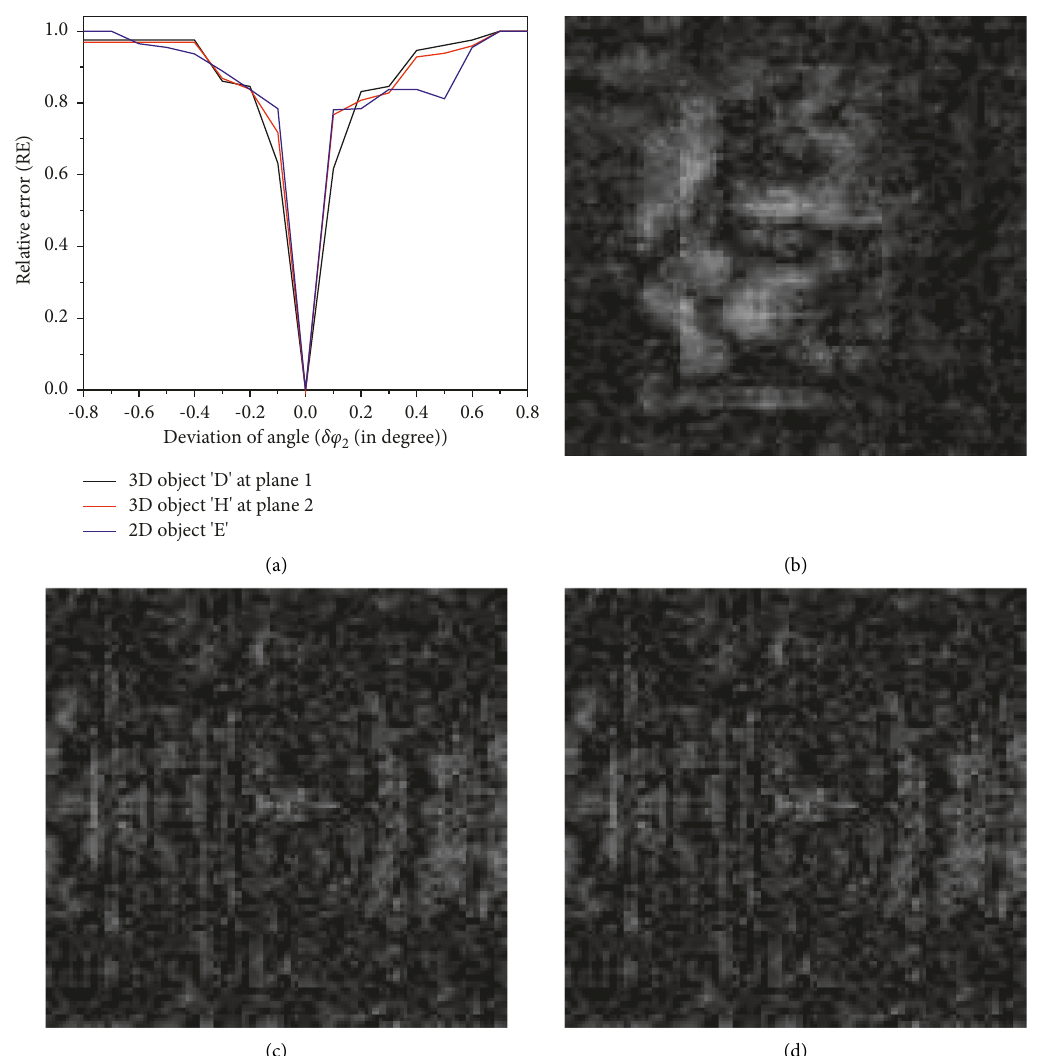
Figure 15: Decrypted results with wrong angle of Q object with wrong angle φ